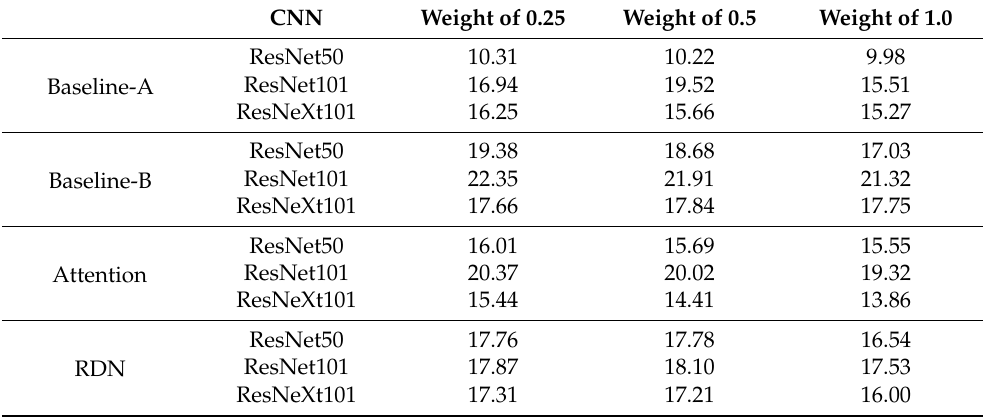
Table 8. CIDEr-score performance based on noise